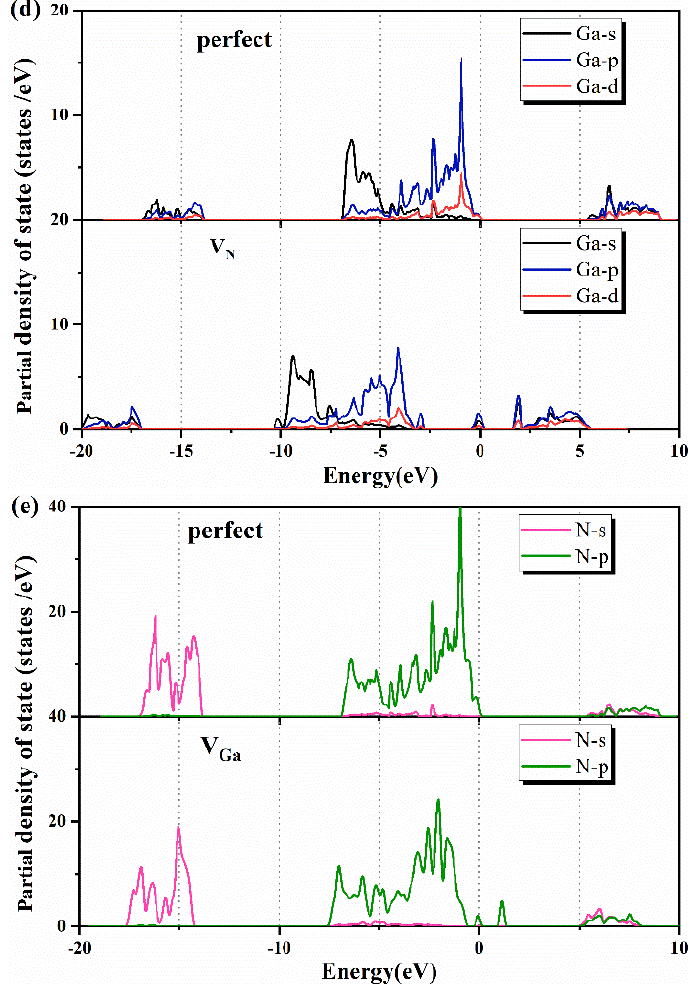
Figure 4. Partial density of states (PDOS) of different defect structures: ( a ) Al i , ( b ) Ga i , ( c ) N i , ( d ) V N , ( e ) V Ga .